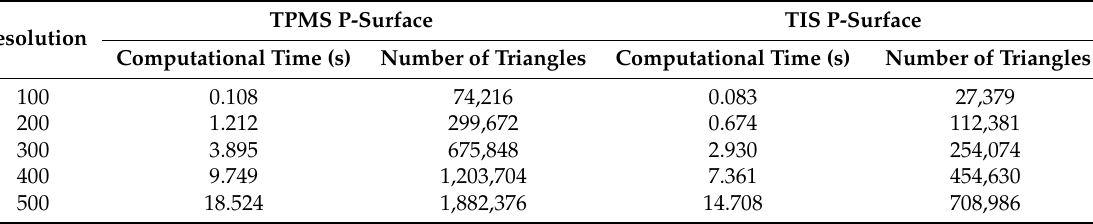
Figure 12. Deformed TPMS and TIS surfaces with a threshold C that exceeds the reasonable range. Table 5. Running time comparison between TPMS and